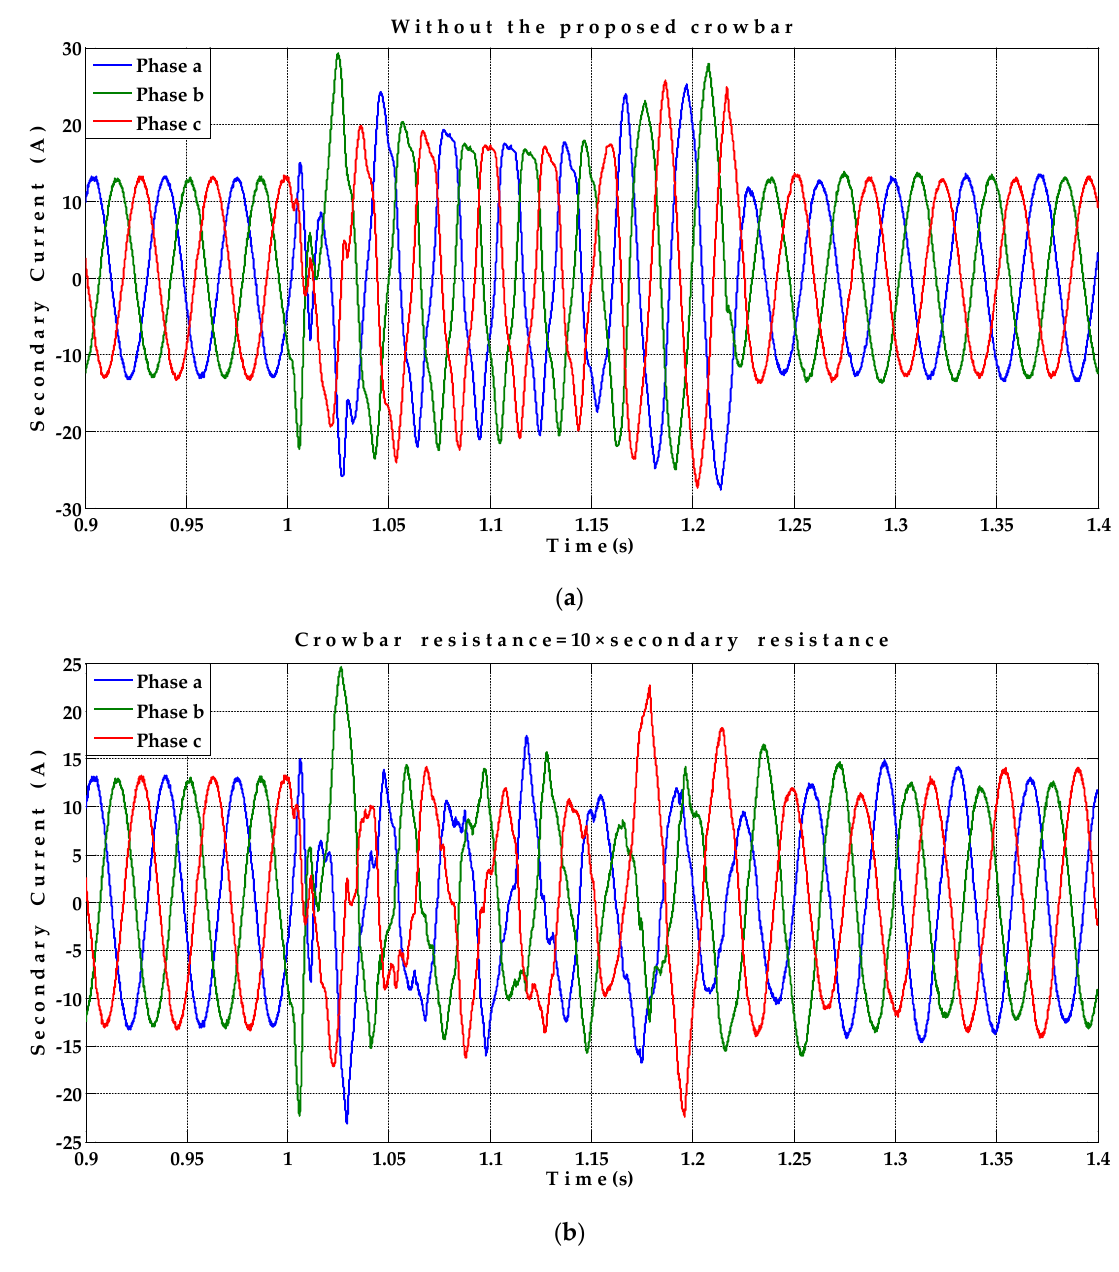
Figure 35. Secondary current of BDFRG without and with the proposed crowbar under double line to ground fault occurrence: ( a ) Without the proposed crowbar; ( b ) With the proposed crowbar. The dc link voltage of the BDFRG (with and without using the proposed crowbar) is shown in Figure 36, which has a reference value equal to 710 V. Under the fault occurrence, in the case of “without using the proposed crowbar”, the dc link voltage was decreased to about 595.5 V. In the case of using the proposed crowbar, the dc link voltage, during the fault, at first decreased to 667.2 V and then increased to about 766.4 V; then, the dc link voltage improved and returned to its pre-fault value.